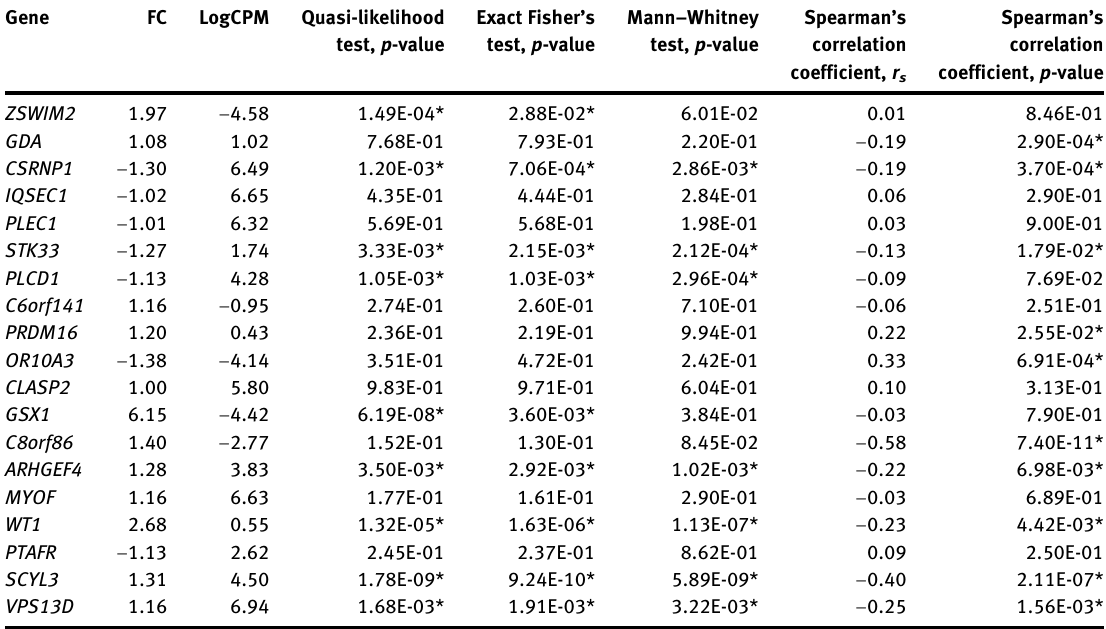
Table  : Differentially expressed genes associated with the high-risk group of PC.